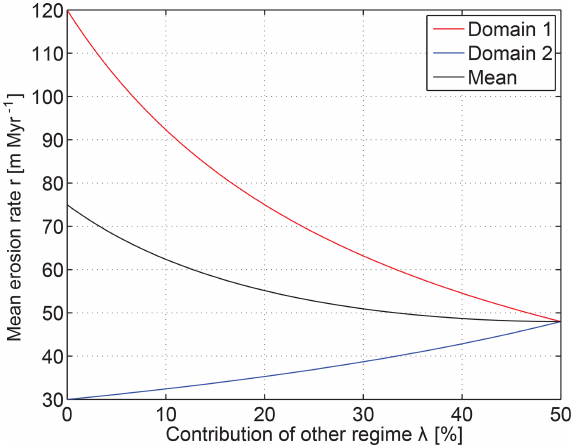
Figure 11. Three scenarios of intermittent phases of sedimentation. Solid curves: depth of burial of the present-day surface. Dashed lines: time intervals of crater production where a crater of a given depth H would be detectable at the present surface. Dotted lines: equivalent erosional histories (same expected number of craters) with constant erosion